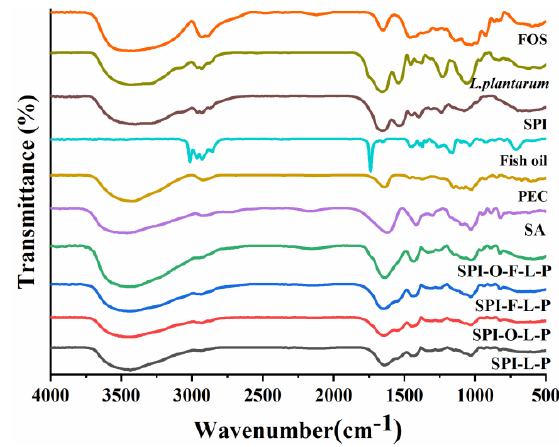
Figure 4. FTIR spectra of different